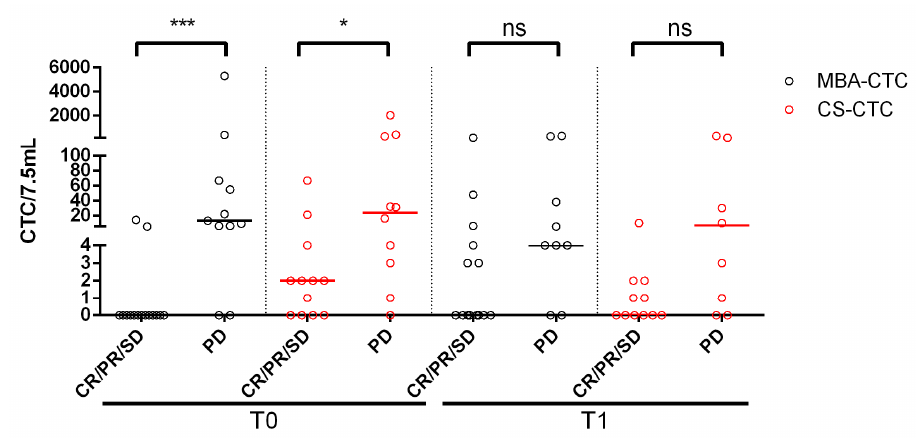
Figure 3. Comparison between CTC levels as detected by the metabolic-based assay (MBA) and CellSearch (CS) and imaging. This plot shows the CTC count for individual patients at baseline (T0) and follow-up (T1), compared with their response at the first follow-up imaging. (CR/PR/SD = Complete Response/Partial Response/Stable Disease; PD = Progressive Disease. Statistical significance was calculated by Mann-Whitney test (*** p = 0.0001, * p = 0.027, ns = not significant (CS-CTCs: p = 0.05; MBA-CTCs: p = 0.07).